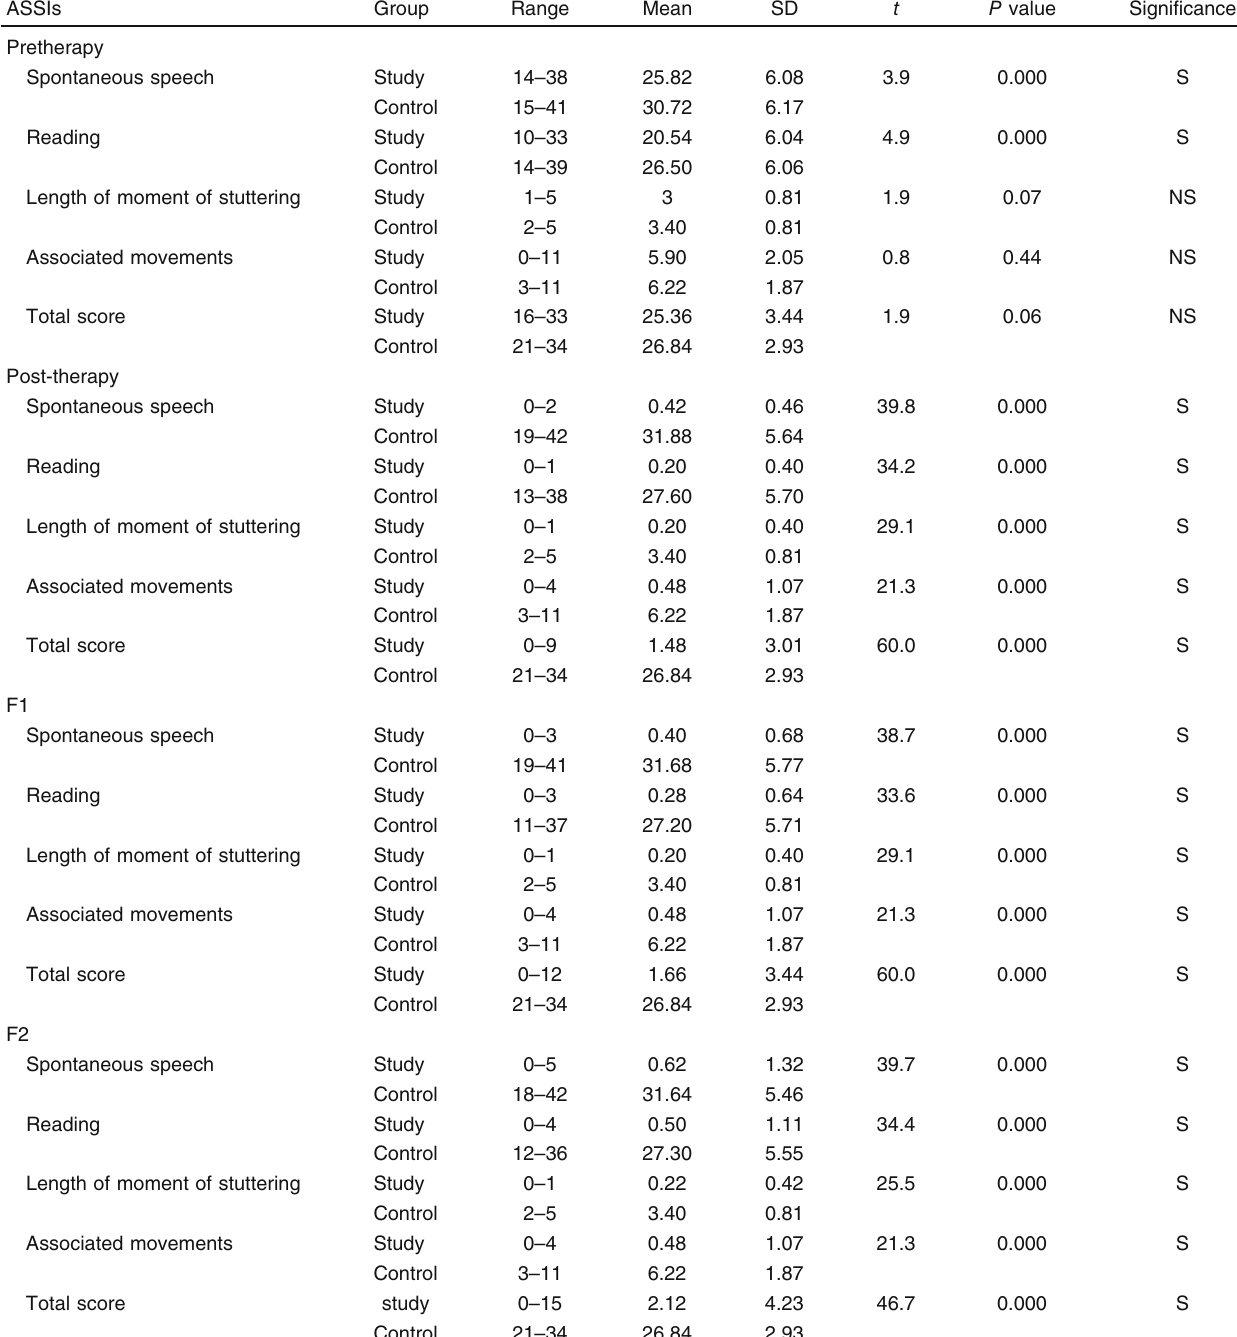
Table 5 Comparison between the study group and the control group as regards Stuttering Severity Instrument for Children and Adults-Arabic version